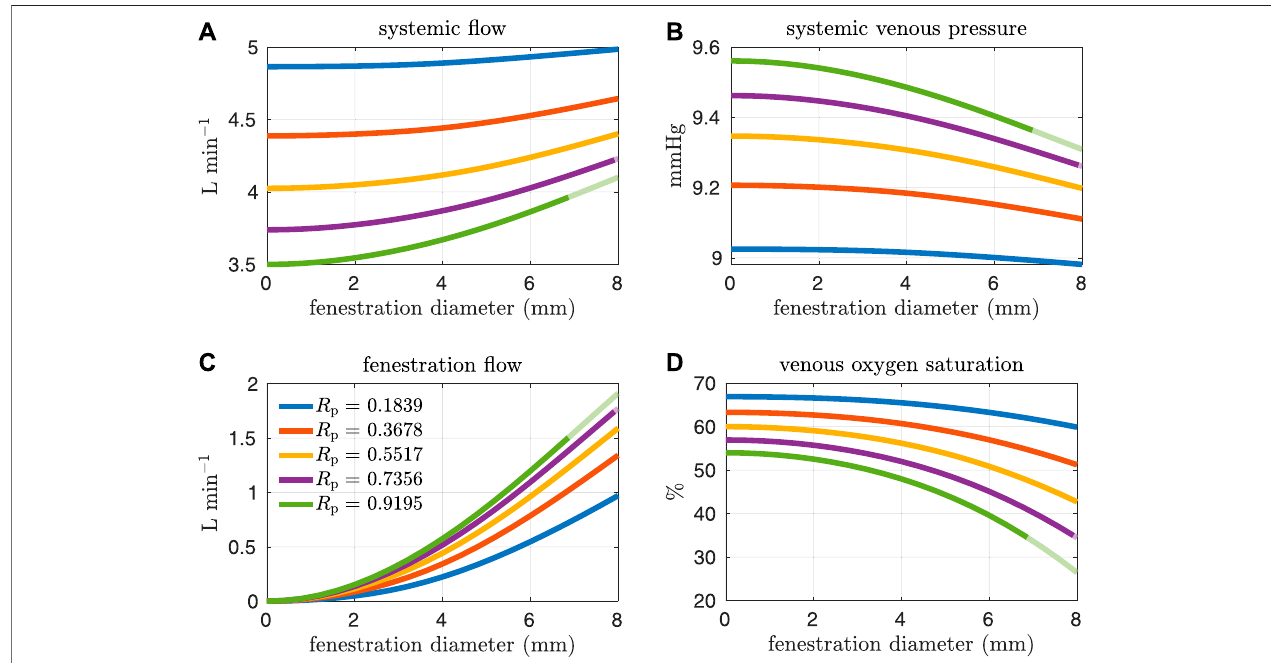
FIGURE 4 | Results corresponding to oxygen consumption equal to − 0.3236 L min − 1 . Pulmonary resistance values R p centered around our baseline value are considered.Meanvalues fordifferent hemodynamic and oxygentransportvariables areplottedasfunctions ofthefenestration diameter. (A) systemic fl ow, (B) systemic venous pressure, (C) fenestration fl ow, (D) venous oxygen